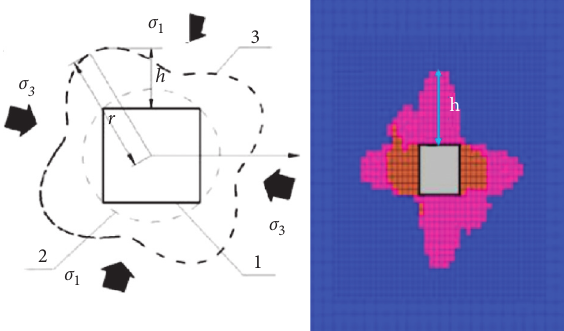
Figure 9: Roof caving in the butterfly-shaped plastic zone of the roadway with fractured surrounding rock